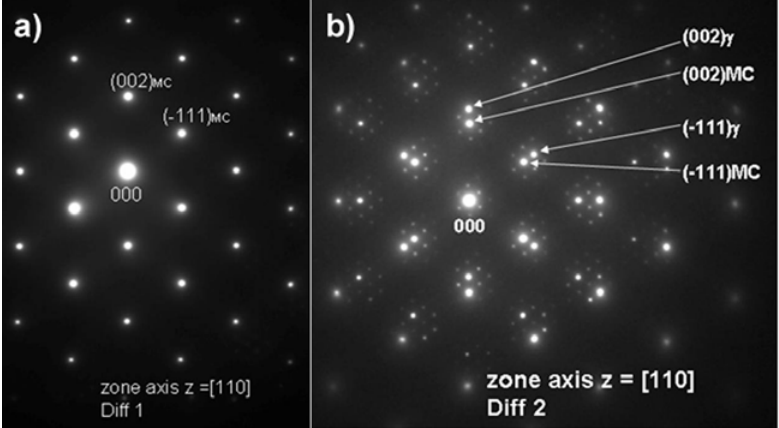
Figure 6. Selected area electron diffraction patterns for the MC phase constituent shown in ( a ) together with superimposed Moiré electron diffraction pattern for MC and γ phase in ( b ).